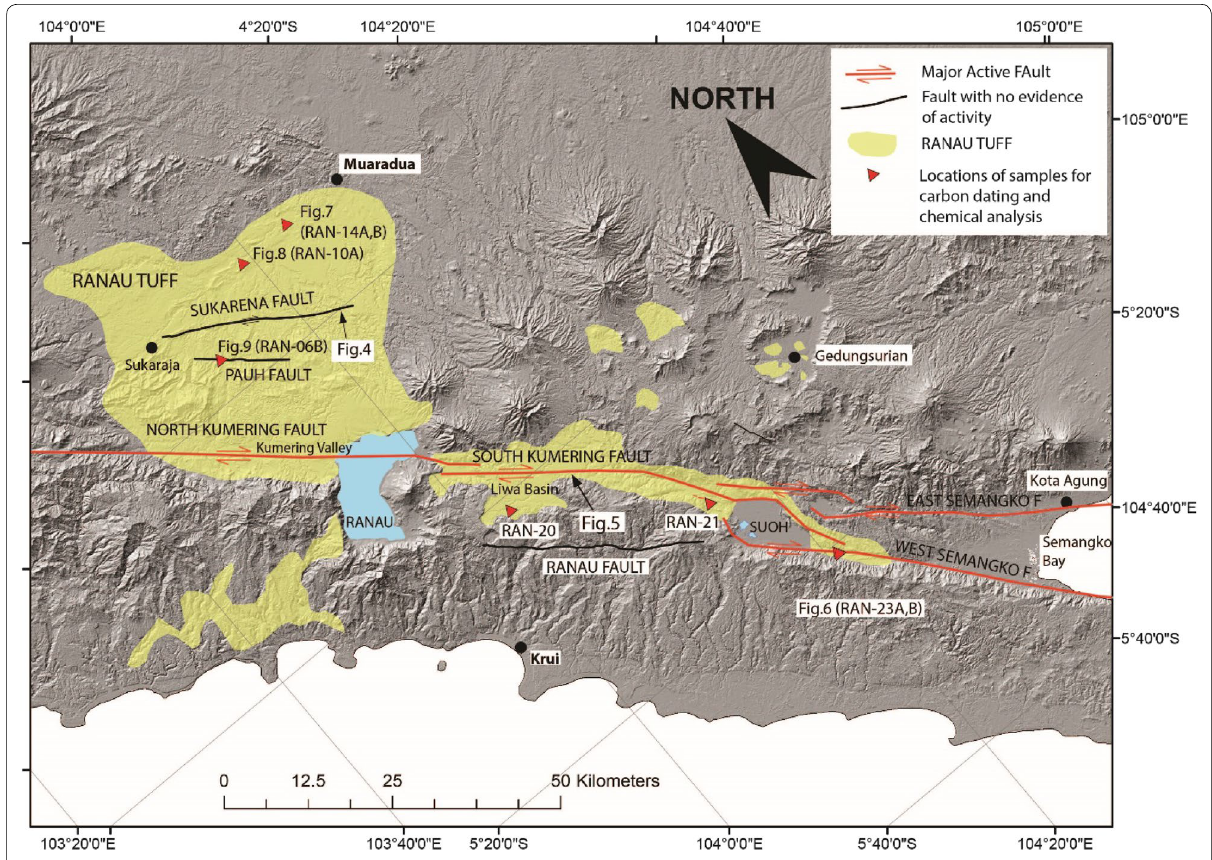
Fig. 2 Distribution of the Ranau Tuff, revised from Amin et al. (1993) and Gafoer et al. (1986) plus our own observations. Red dots are locations of studied samples. Shaded relief map is developed from SRTM 1 arc-second